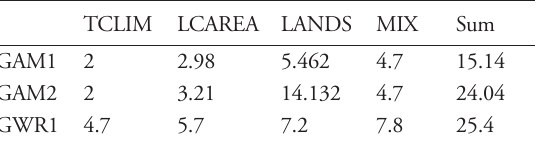
Table 4. Estimated degrees of freedom (EDF) used by GAM1, GAM2 and GWR